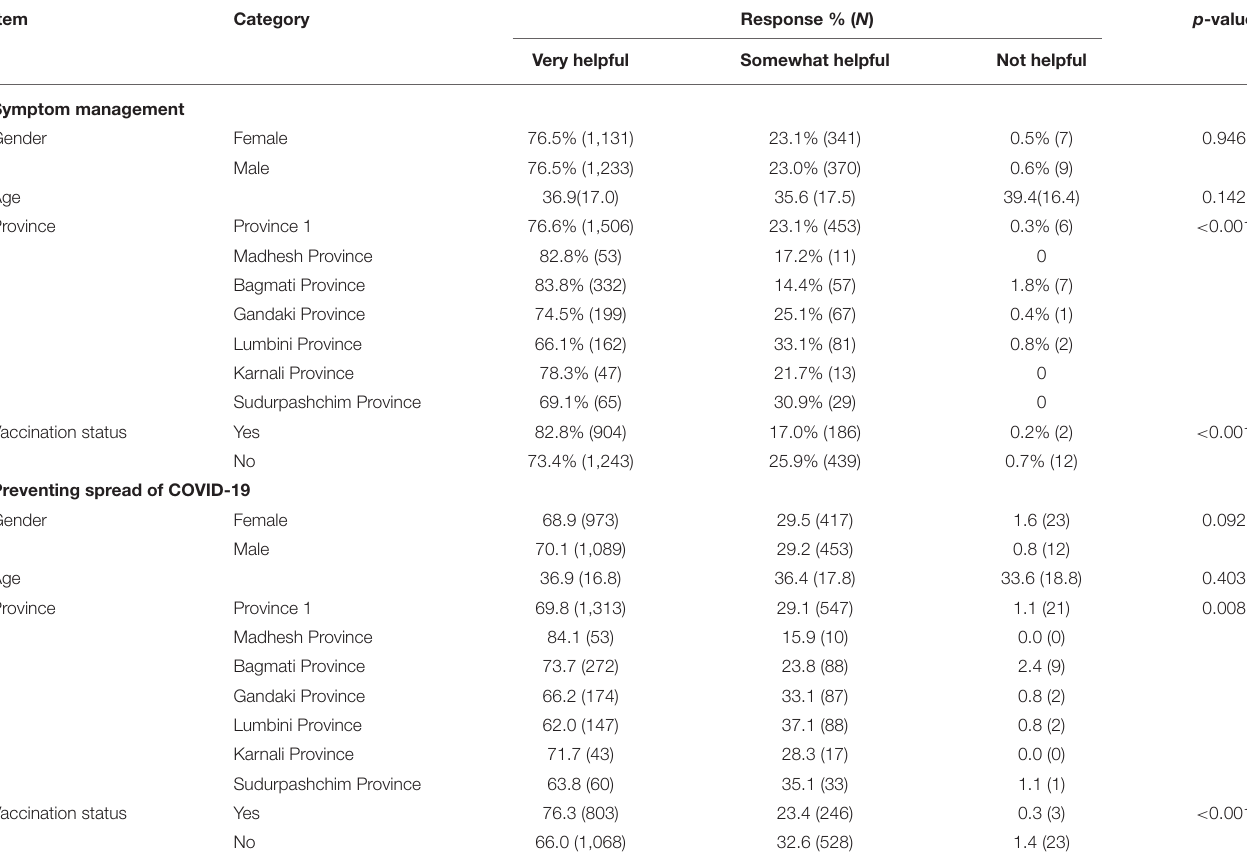
TABLE 3 | “Symptom management” and “Preventing spread of COVID-19” by gender, age, province, and vaccination status.